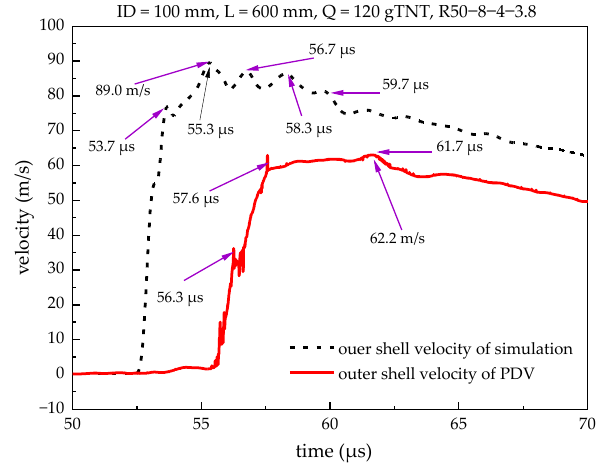
Figure 18. Magnification of the front velocity waveform.